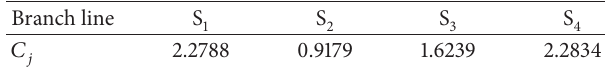
Table 3: SK relative energy